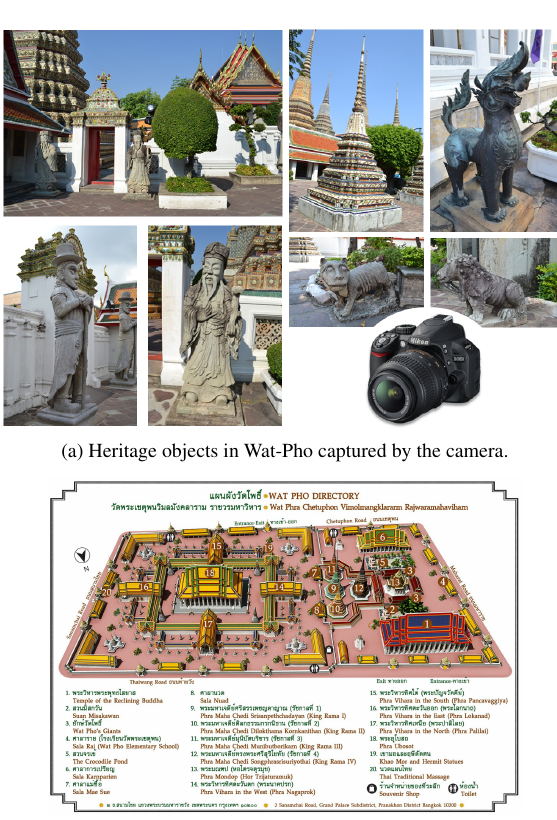
Figure 1: Wat-Pho images and